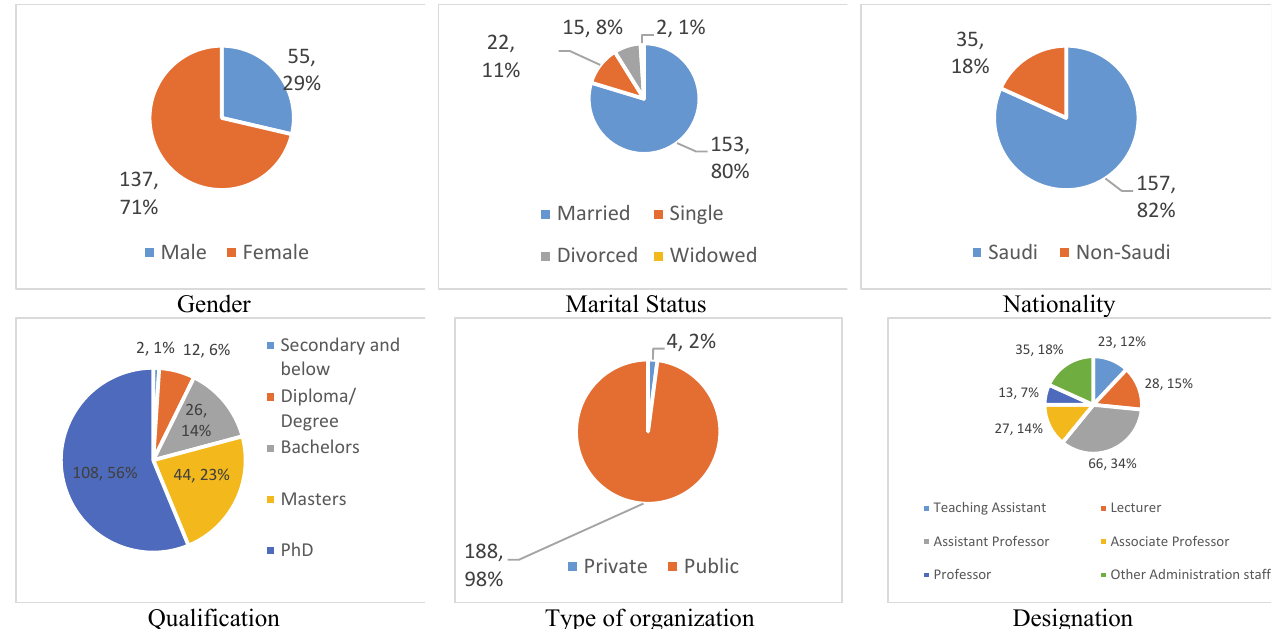
Fig. 1. Personal characteristics of the